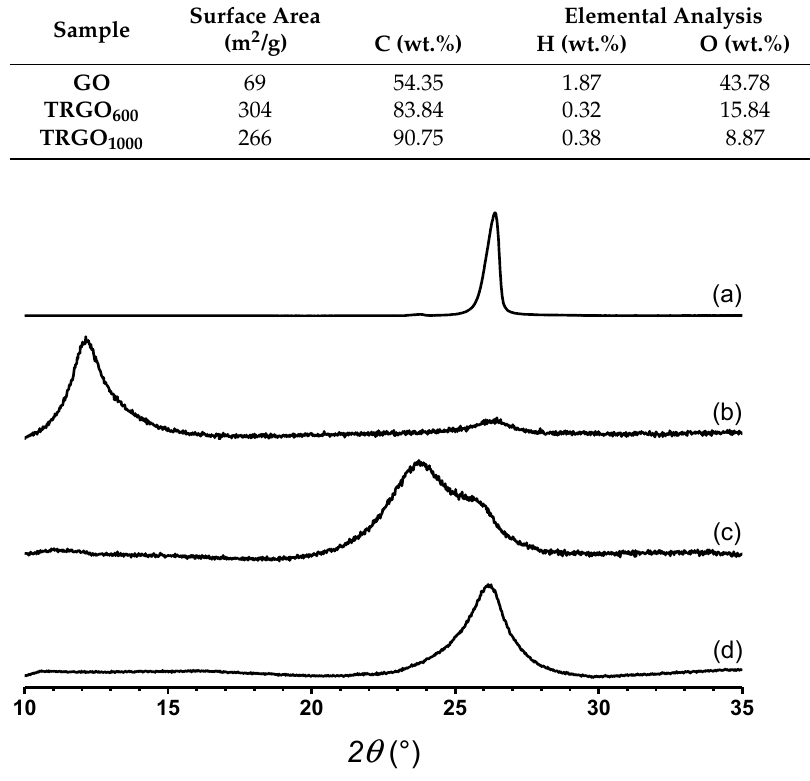
Figure 1. Normalized X-ray diffraction patterns of graphite ( a ), GO ( b ), TRGO 600 ( c ), and TRGO 1000 ( d ). The angle of the diffraction plane, interplanar distance ( d ), crystal size ( D ), and the number of stacked graphene layers ( N L ) estimated for the different samples in Table 2 are shown. It is observed that graphite presents a peak at 26.3 ◦ , which corresponds to the (002) plane. This is associated with the distance between the graphene layers. Graphite presents an interlayer distance of 0.338 nm, a crystal size of 18.61 nm, and 56 stacked layers. Because of the oxidation process, the interlayer distance observed in GO is 0.723 nm, which is higher than that observed in graphite. The decrease in both the crystal size and the number of stacked layers is also observed. This indicates that the oxidation process not only favors the functionalization of the graphene layer with oxygen moieties which increases the interlayer distance, but it also reduces the crystallinity and favors the partial delamination of graphite. The temperature of the reduction process had an impact on the interlayer distance of the reduced graphene oxide layers. TRGO 600 presents a distance of 0.355 nm, a crystal size of 3.71 nm, and 11 stacked layers, while TRGO 1000 presents a peak associated to the (002) plane and the interlayer distance is similar to that of graphite, but the number of stacked layers is 13, which is lower than in